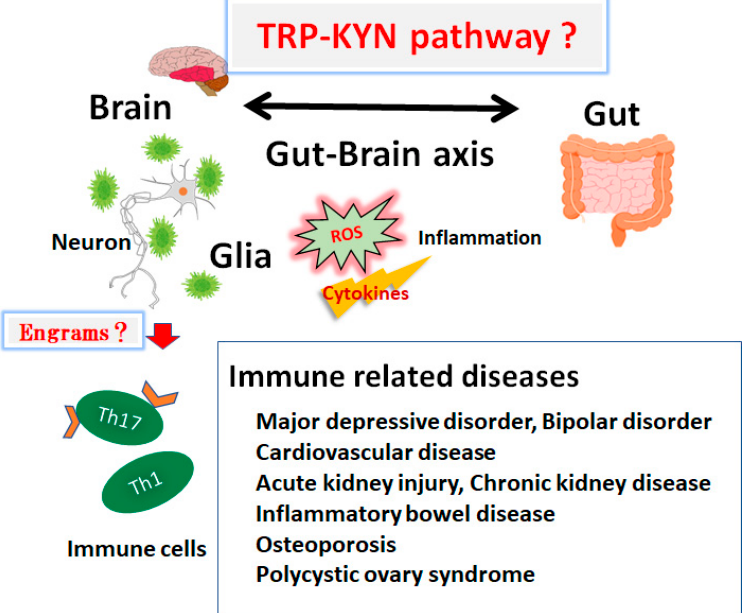
Figure 3. Schematic overview for the pathogenesis of immune-related diseases such as major de- pressive disorder, bipolar disorder, cardiovascular diseases, acute kidney injury, chronic kidney disease, inflammatory bowel disease, osteoporosis, and polycystic ovary syndrome. The gut–brain axis with tryptophan (TRP) and kynurenine (KYN) pathway might contribute to the pathogenesis of immune-related diseases via the formation of several “Engrams” in brain. Inflammation with several cytokines and/or reactive oxygen species (ROS) may be also involved in the modification of immune cells. Note that several important activities such as cytokine induction or anti-inflamma- tory reaction have been omitted for clarity.